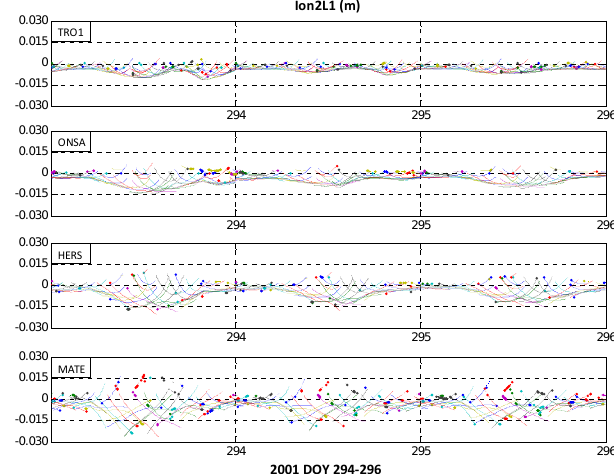
Fig. 5. STEC (TECU) for the observation stations on DOY 294‐296 in 2001.